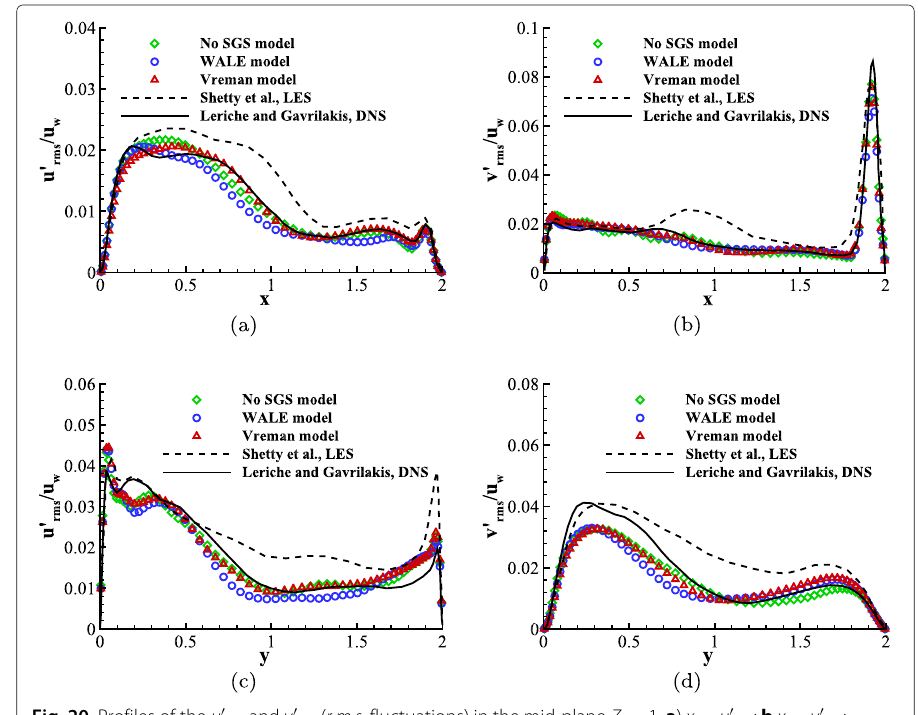
Fig. 20 Profiles of the u (cid:11) rms and v (cid:11) rms ( r.m.s. fluctuations) in the mid-plane Z = 1. a ) x − u (cid:11) rms ; b x − v (cid:11) rms ; c y − u (cid:11) rms ; d y − v (cid:11) rms